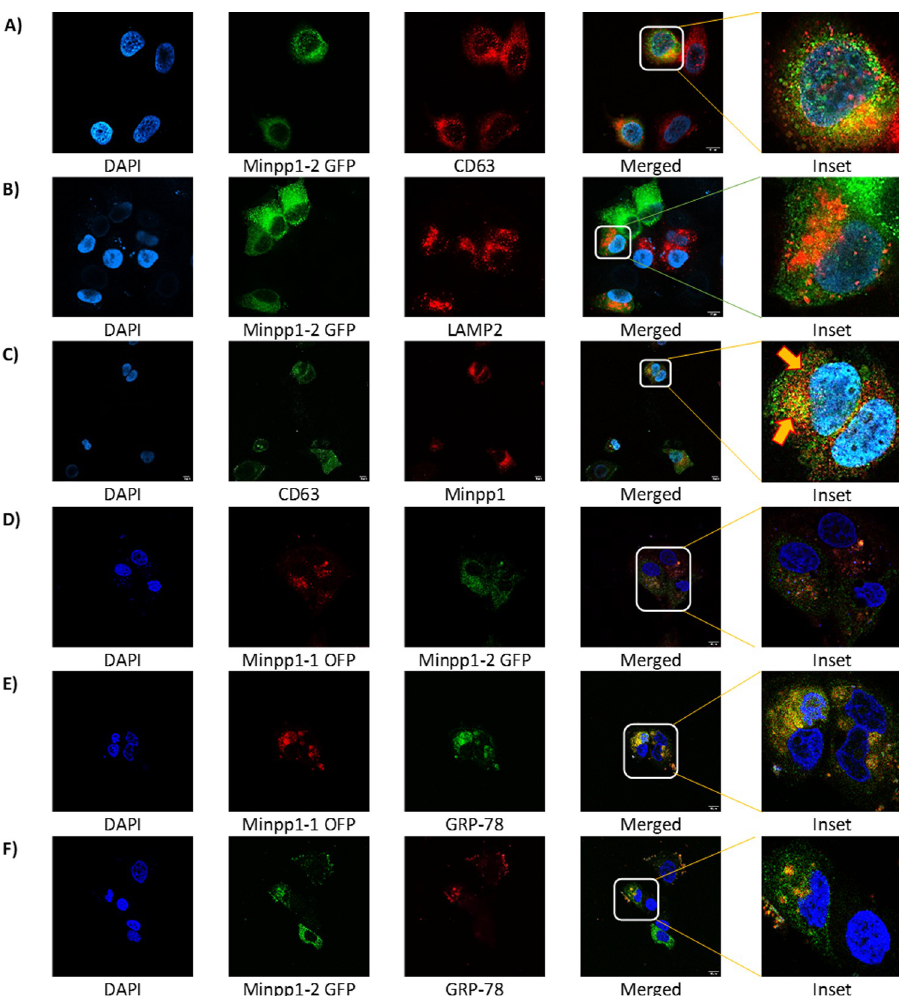
Fig 7. Confocal immunofluorescence image analysis on 4% paraformaldehyde (PFA) fixed MCF-7 cells: A). hMinpp1 isoform-2 GFP transfected MCF-7 cells were immuno-stained with Mouse anti-CD63 antibody (MVB/exosomes biomarker). B). hMinpp1 isoform-2 GFP transfected MCF-7 cells were immunostained with mouse anti-LAMP2 antibody (Lysosomal biomarker). C). Cells were immunostained with Rabbit anti-Minpp1 and Mouse anti-CD63 antibody (MVB/exosomes biomarker). D). Minpp1 isoform-1 OFPSpark and Minpp1 isoform-2 GFP transfected MCF-7 cells. E&F). Minpp1 isoform-1 OFPSpark and Minpp1 isoform-2 GFP transfected MCF-7 cells were stained with mouse anti-GRP-78 antibody (ER biomarker). Secondary antibody staining was done by goat anti-mouse Alexa Fluor 555 (Red); Goat anti-mouse Alexa flour 488 (Green); Goat anti-mouse Alexa Fluor 647 (far Red); and goat anti- rabbit Alexa flour 555 (Red). Nuclei were stained with DAPI (blue). Scale bar is 10 μ m.